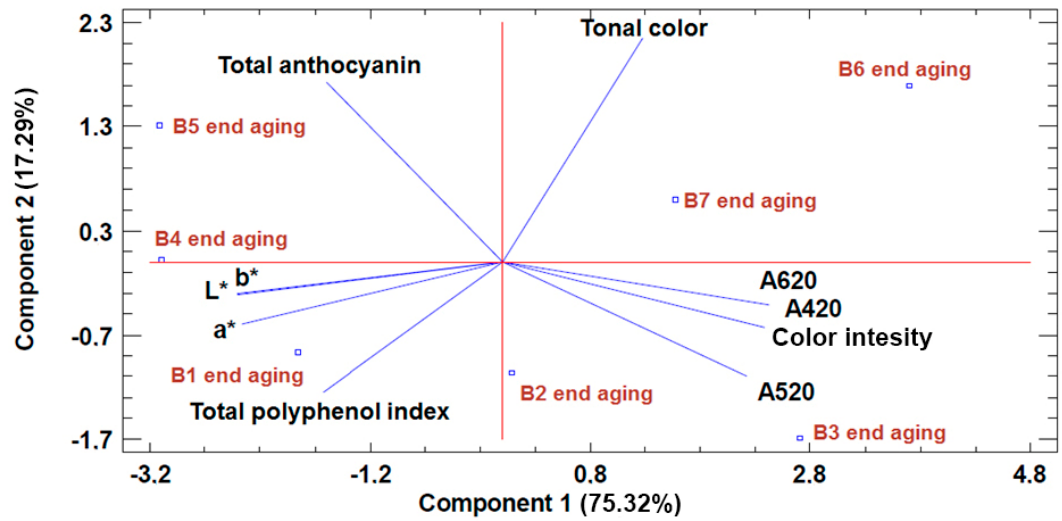
Figure 4. PCA of the color intensity parameters A420, A520, A620, hue, and CIELab parameters (L*, a*, b*). TPI and total anthocyanins of the wines aged in the barrels studied.